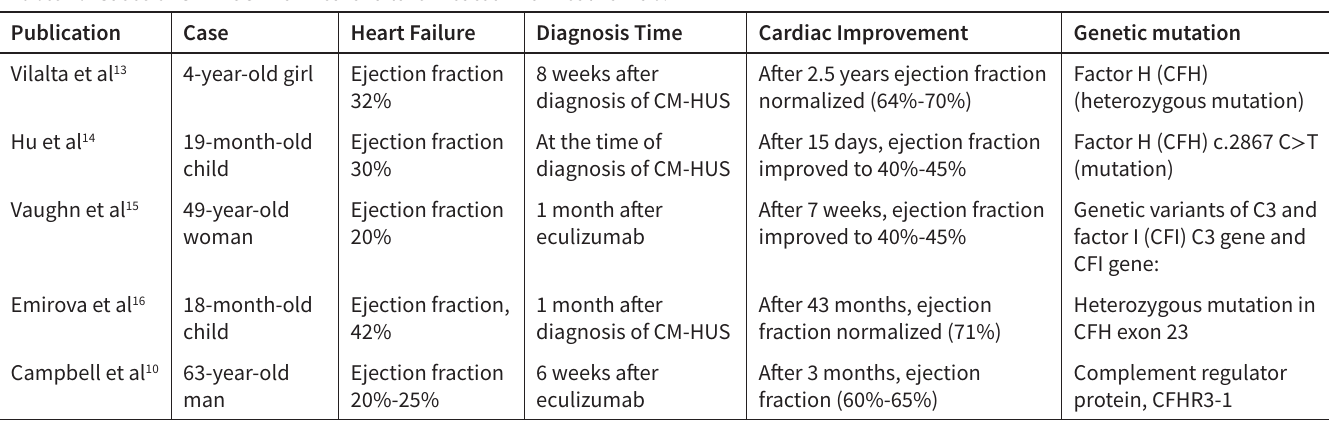
Table 1. Cases of CM-HUS with Heart Failure Treated with